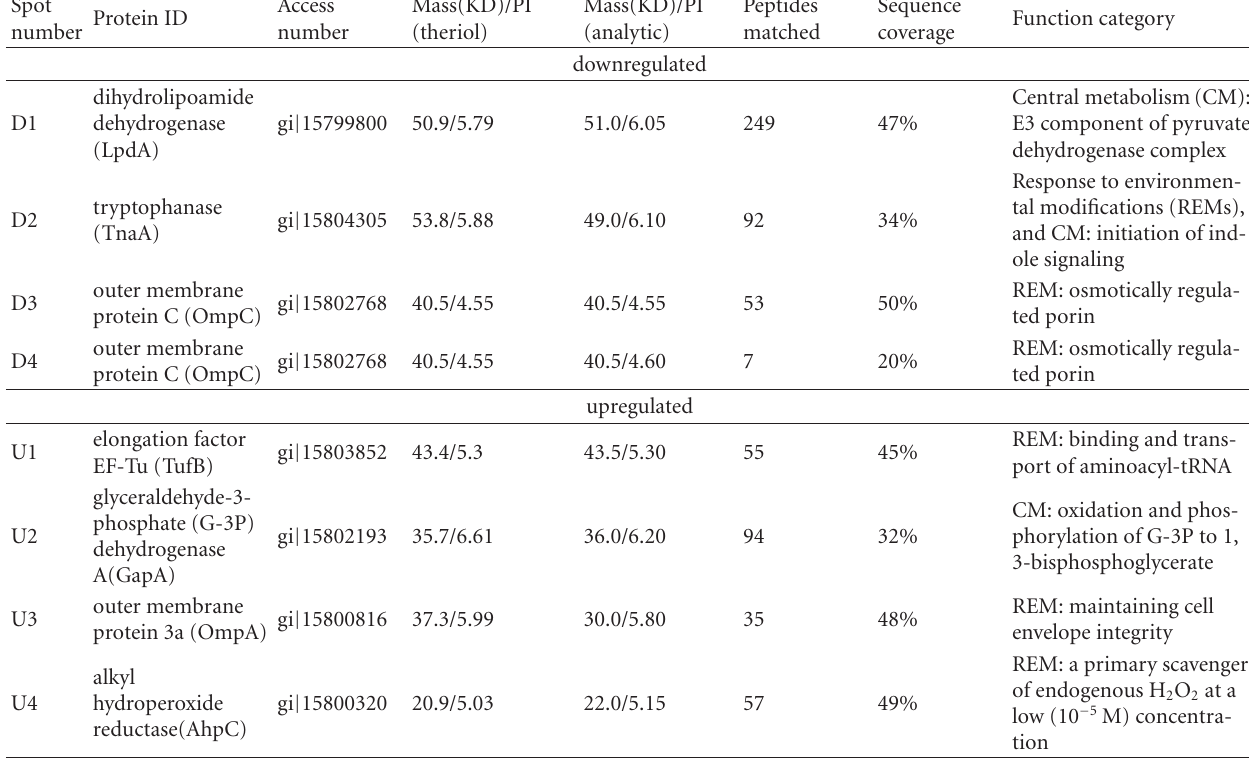
Table 3: Identification of di ff erentially displayed proteins in 2D